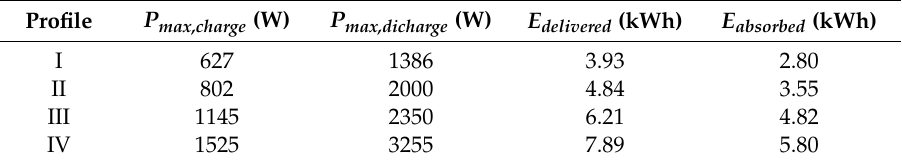
Table 3. Characteristics of the battery profiles tested on the commercial BESS.